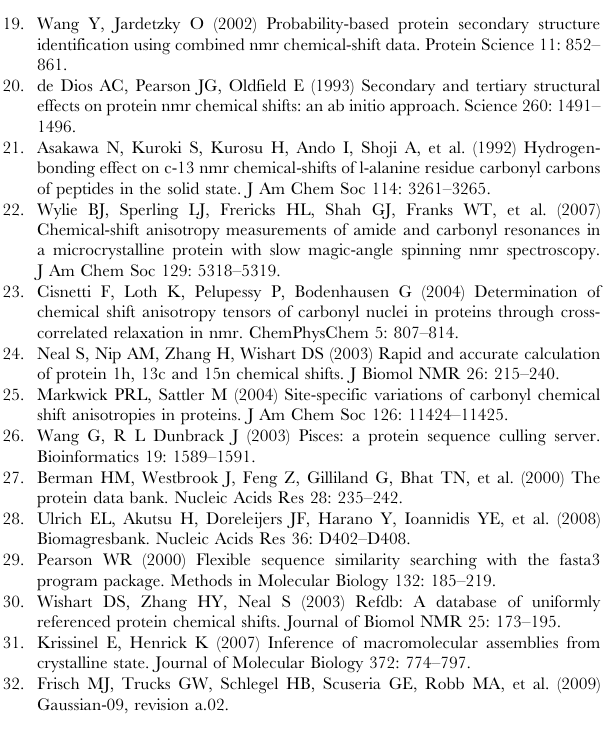
Figure S1 d , h -space Analysis of Experimental Struc- tures. Plot of the distance ( d ) and angle ( h ) measured between each of the 45,792 pairs of carbonyls with a potential n { p (cid:1) interaction. The relative density of points in the occupied d and h space was used to generate a transparency mask for Figure 1. (TIF) Figure S2 Ramachandran-space Analysis of Experimen- tal Structures. Ramachandran plot of carbonyls with 13 C chemical shift differences relative to random coil that are w 2.5 ppm. The acceptor carbonyls from each pair of carbonyls with d and h values within the optimal limits for an n { p (cid:1) interaction are colored red. (TIF) Figure S3 Supplemental Quantum Chemical Calcula- tion Plots. ( A ) Plot of the residuals for the fit of the chemical shielding surface to a function proportional to the dipole-dipole energy. ( B ) Summary of the quantum chemical calculations of the hydrogen bond contribution to the dipole-dipole interaction; plot of carbonyl 13 C chemical shielding ( s ) as a function of the hydrogen bond angle ( h ) and distance ( d O { N ).